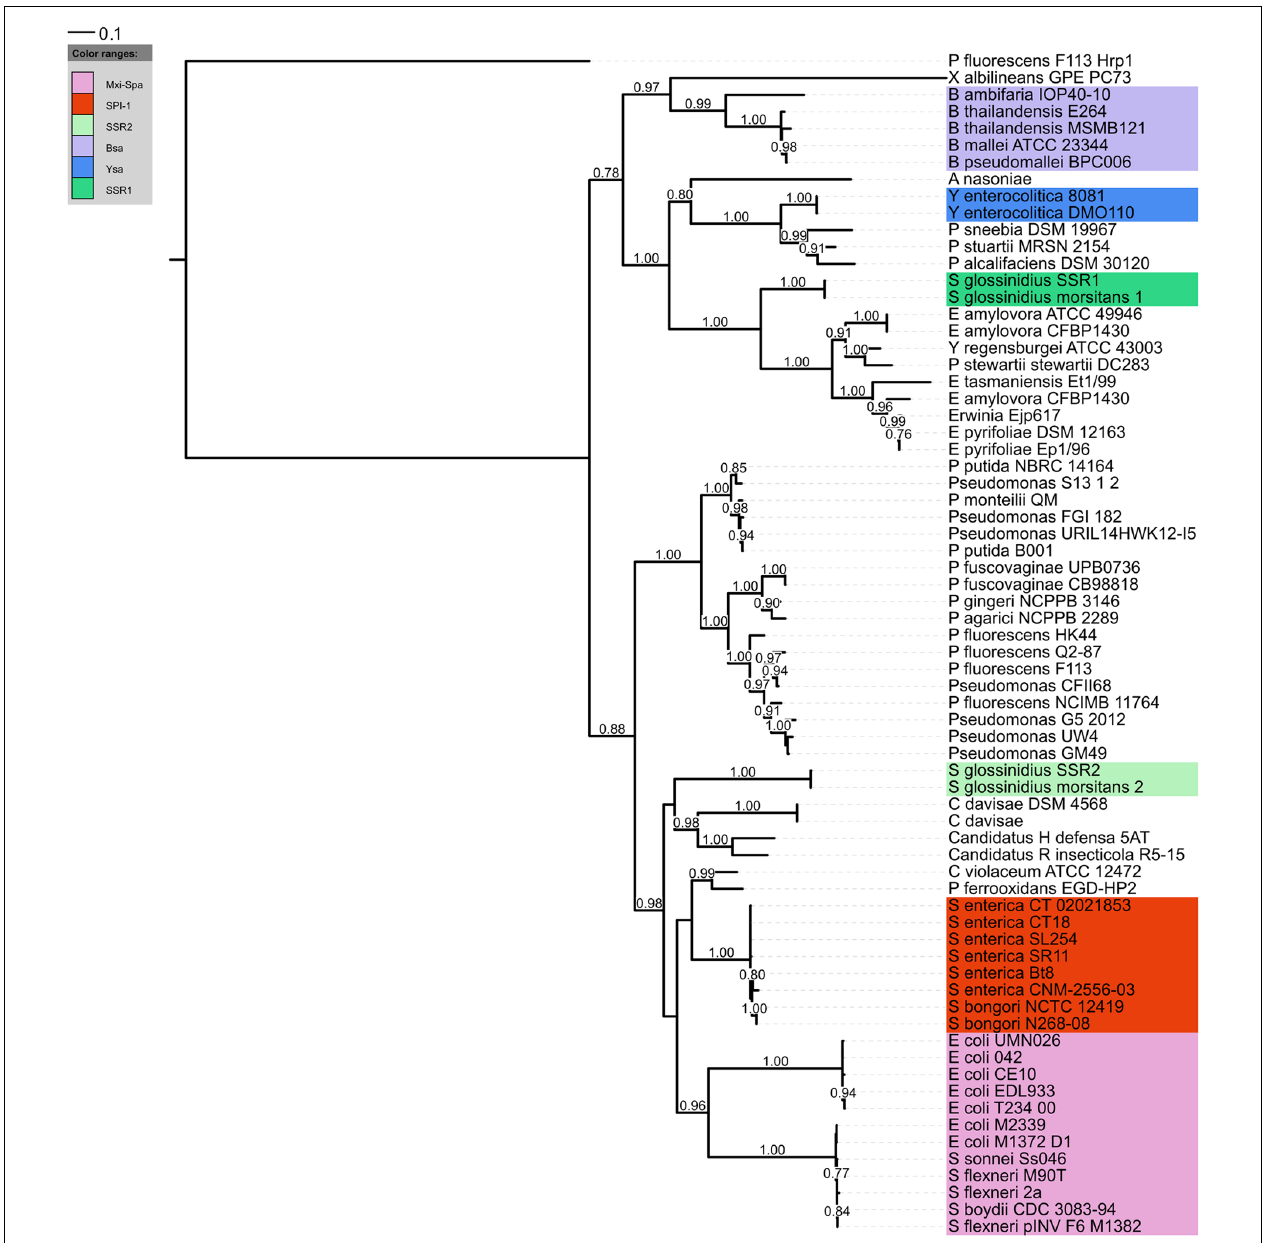
FIGURE 1 | Phylogenetic distribution of the SPI-1T3SS. A distance tree (maximum likelihood based on theWAG model) was calculated from InvA homologs (COG4789) of the SPI-1 family. RscV (COG4789) from the Hrp1T3SS of P. fluorescens F113 was used as an outgroup. Only aLRT support values greater than 0.75 (1000 replicates) are